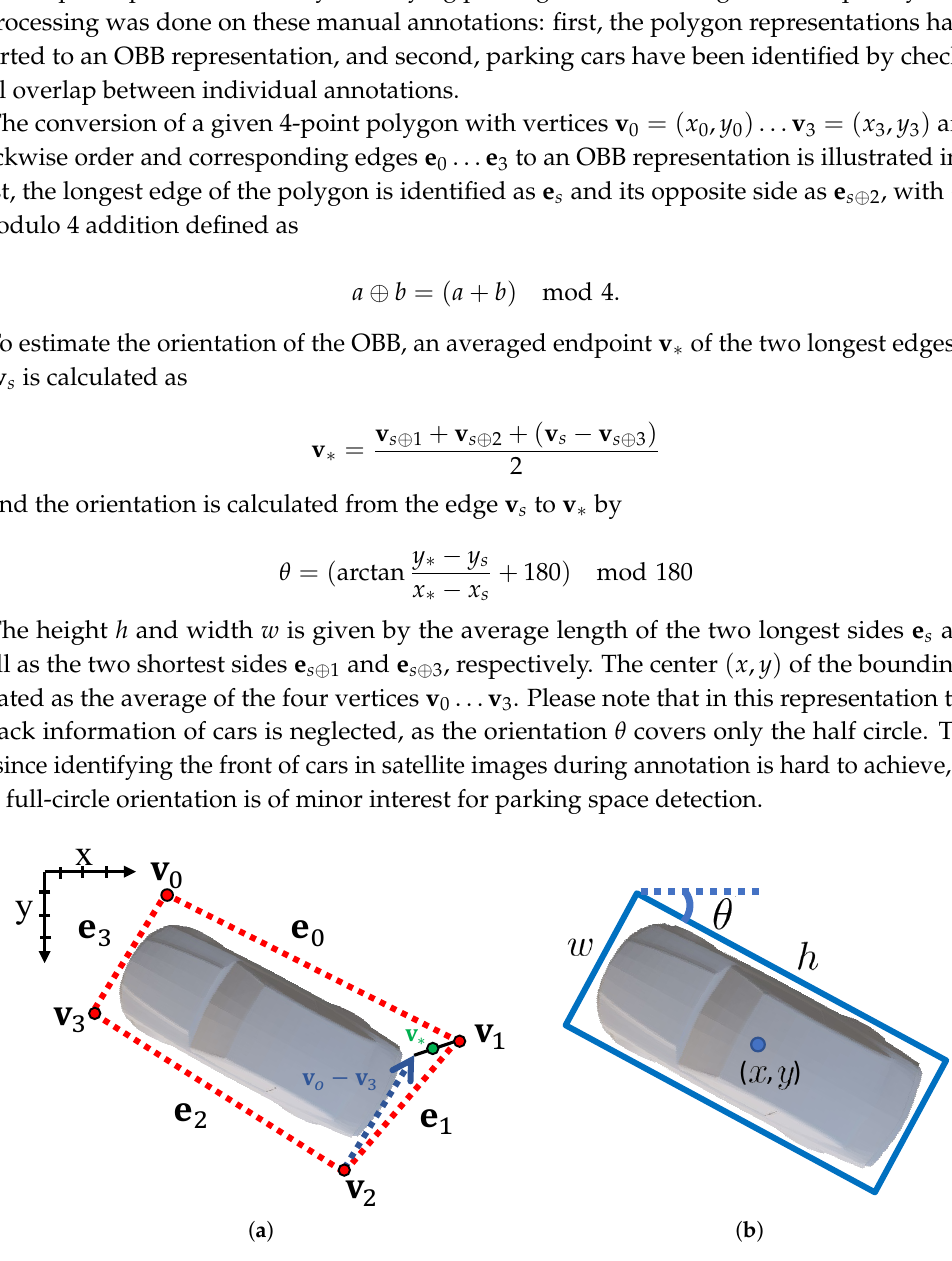
Figure 2. ( a ) A 4-point polygon annotation of a car; ( b ) converted OBB representation described by the five parameters x , y , h , w , and θ